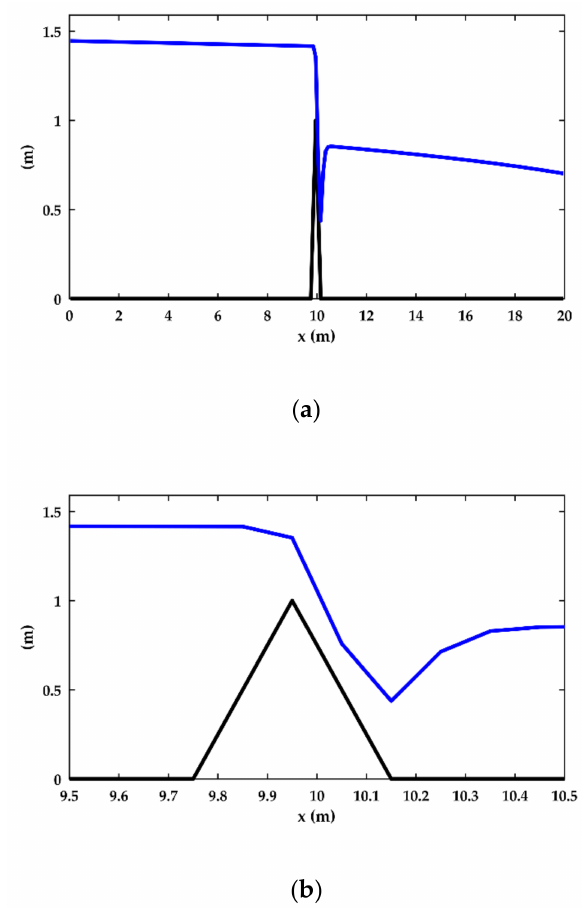
Figure 9. Hydraulic solution for test 4 on the entire domain ( a ) and zoomed on the weir ( b ).